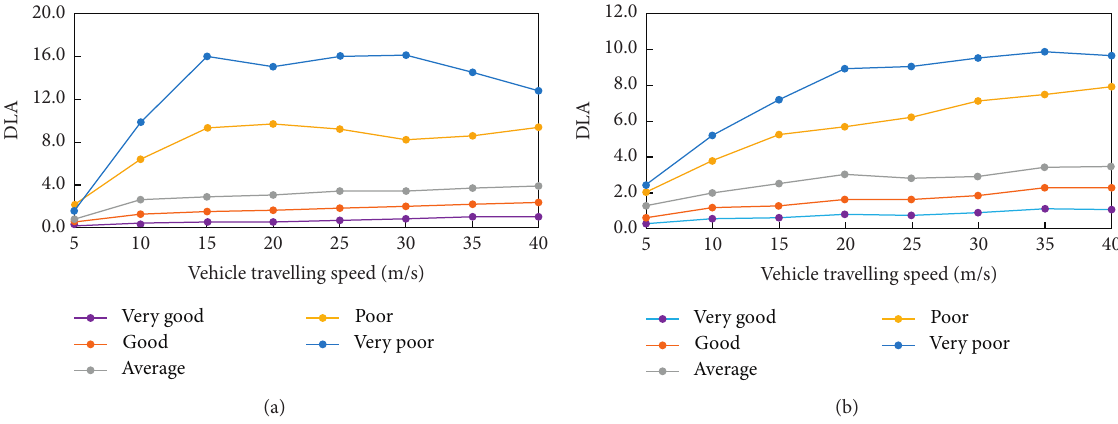
Figure 16: DLA of the suspender: (a) DLA of the shortest suspender (S1); (b) DLA of the longest suspender